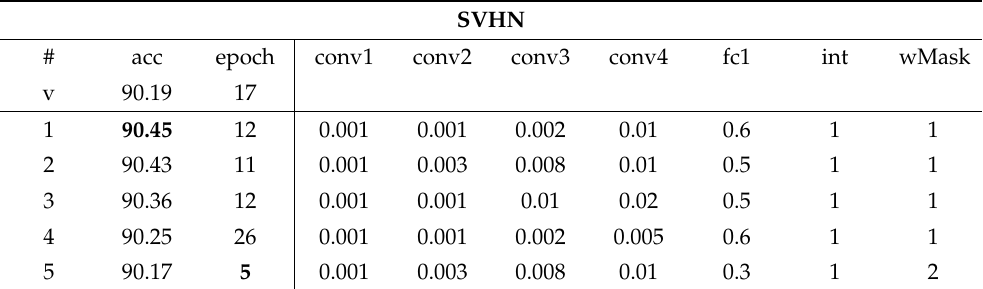
Figure 8. Performances of LIM and vanilla dropout methods on the SVHN dataset, trained and tested for 50 epochs. Graphs were smoothed for better comprehension; original graphs can be seen in the background. Curves correspond to Table 5 scores; black: vanilla, red: 1, green: 2, blue: 3, orange: 4, purple: 5. Table 5. Accuracy scores, parameter tuning, and convergence times for different experiments on the SVHN dataset. The first row holds the best accuracy score for the vanilla dropout version and the epoch at which it was